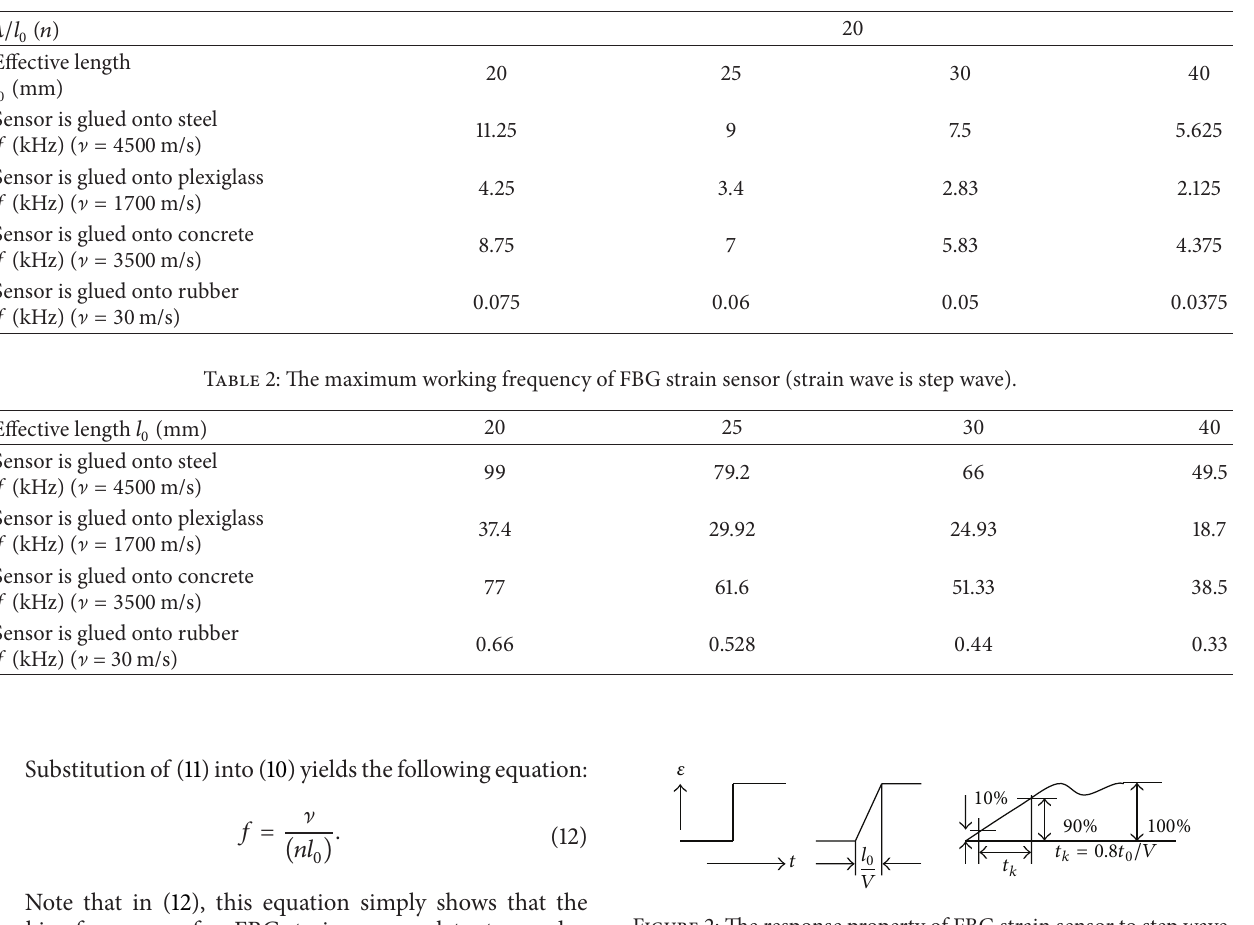
Table 1: Maximum working frequency of FBG strain sensor (strain wave is sine wave).